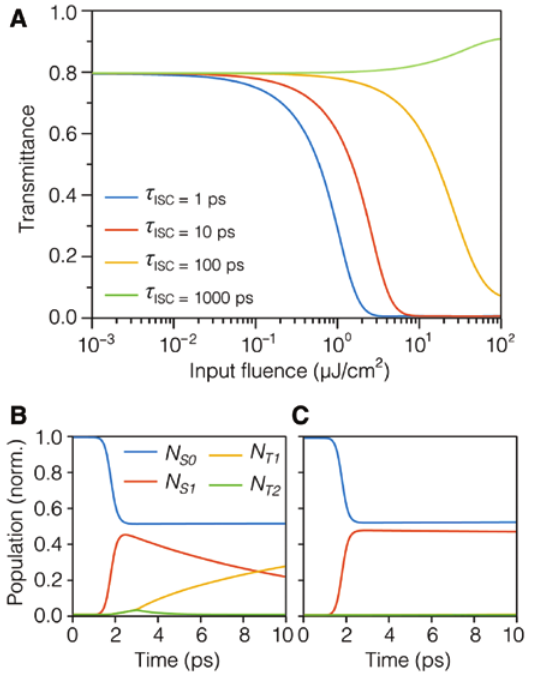
Figure 3: Effect of triplet quantum yield on the RSA efficiency. (A) Transmittance vs. pump fluence at four different values of τ 10, 100, and 1000 ps corresponding to Φ 0.5, respectively. (B) and (C) the population time dynamics at 10 and 1000 ps at a pump energy of 50 μ J/cm 2 .